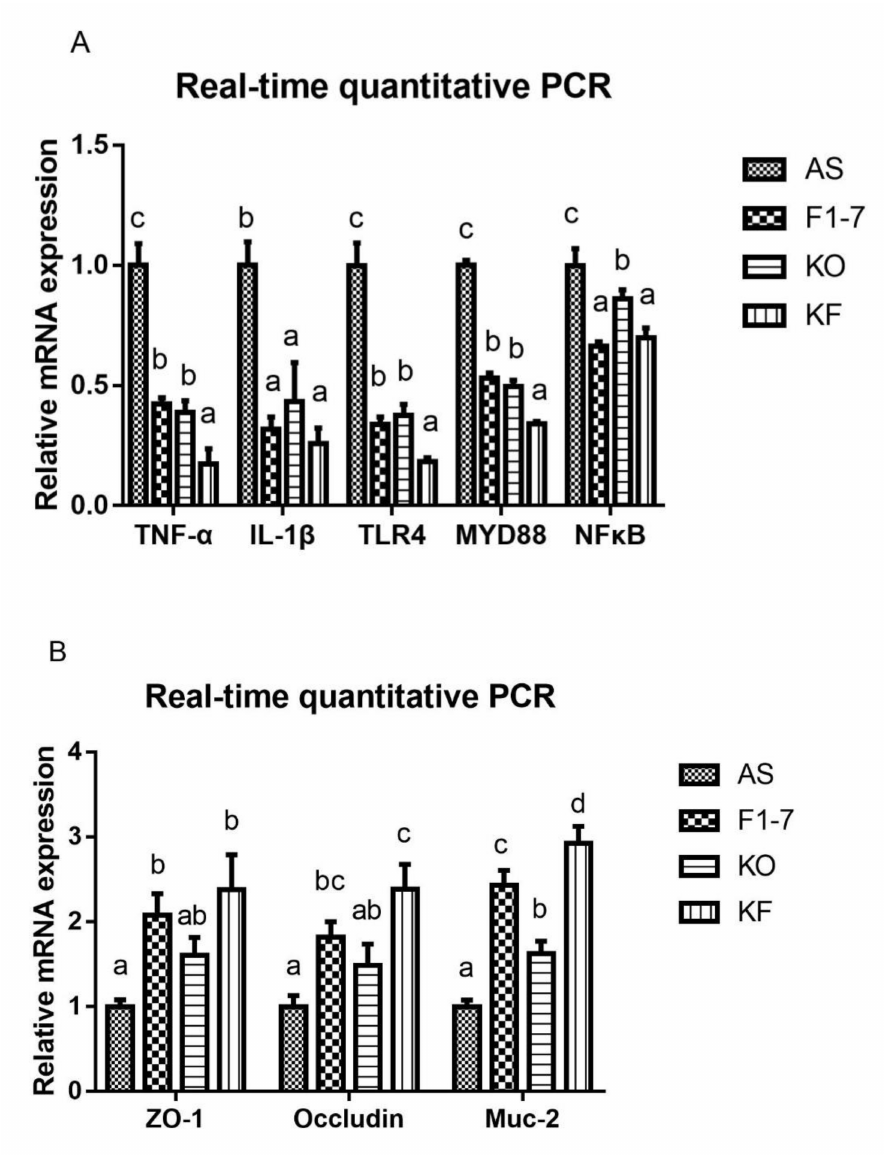
Figure 8. ( A ) Relative mRNA levels of the inflammatory factors in the intestine, containing the genes of TNF- α , IL-1 β , TLR4, MYD88, and NF κ B, and ( B ) mRNA expression of epithelial integrity proteins, Muc-2, occludin, and zonula occludens-1 (ZO-1) (n = 3). Different letters indicate significant differences, p <